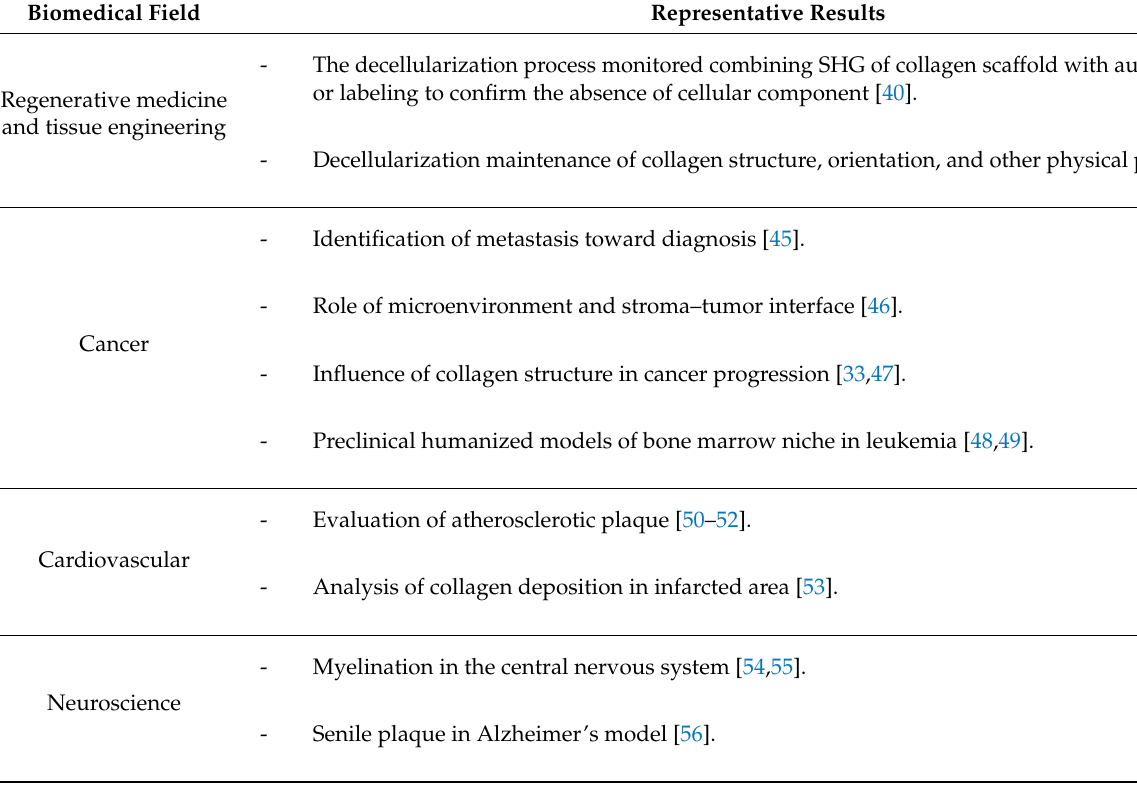
Table 1. Fields of application of label-free multiphoton